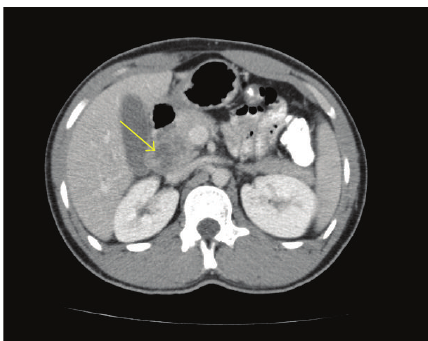
Figure 3: Cell block prepared from the fine needle aspirate of the mass seen in the pancreatic head. Note the appearance of lympho- histiocytic aggregates suggestive of granulomatous